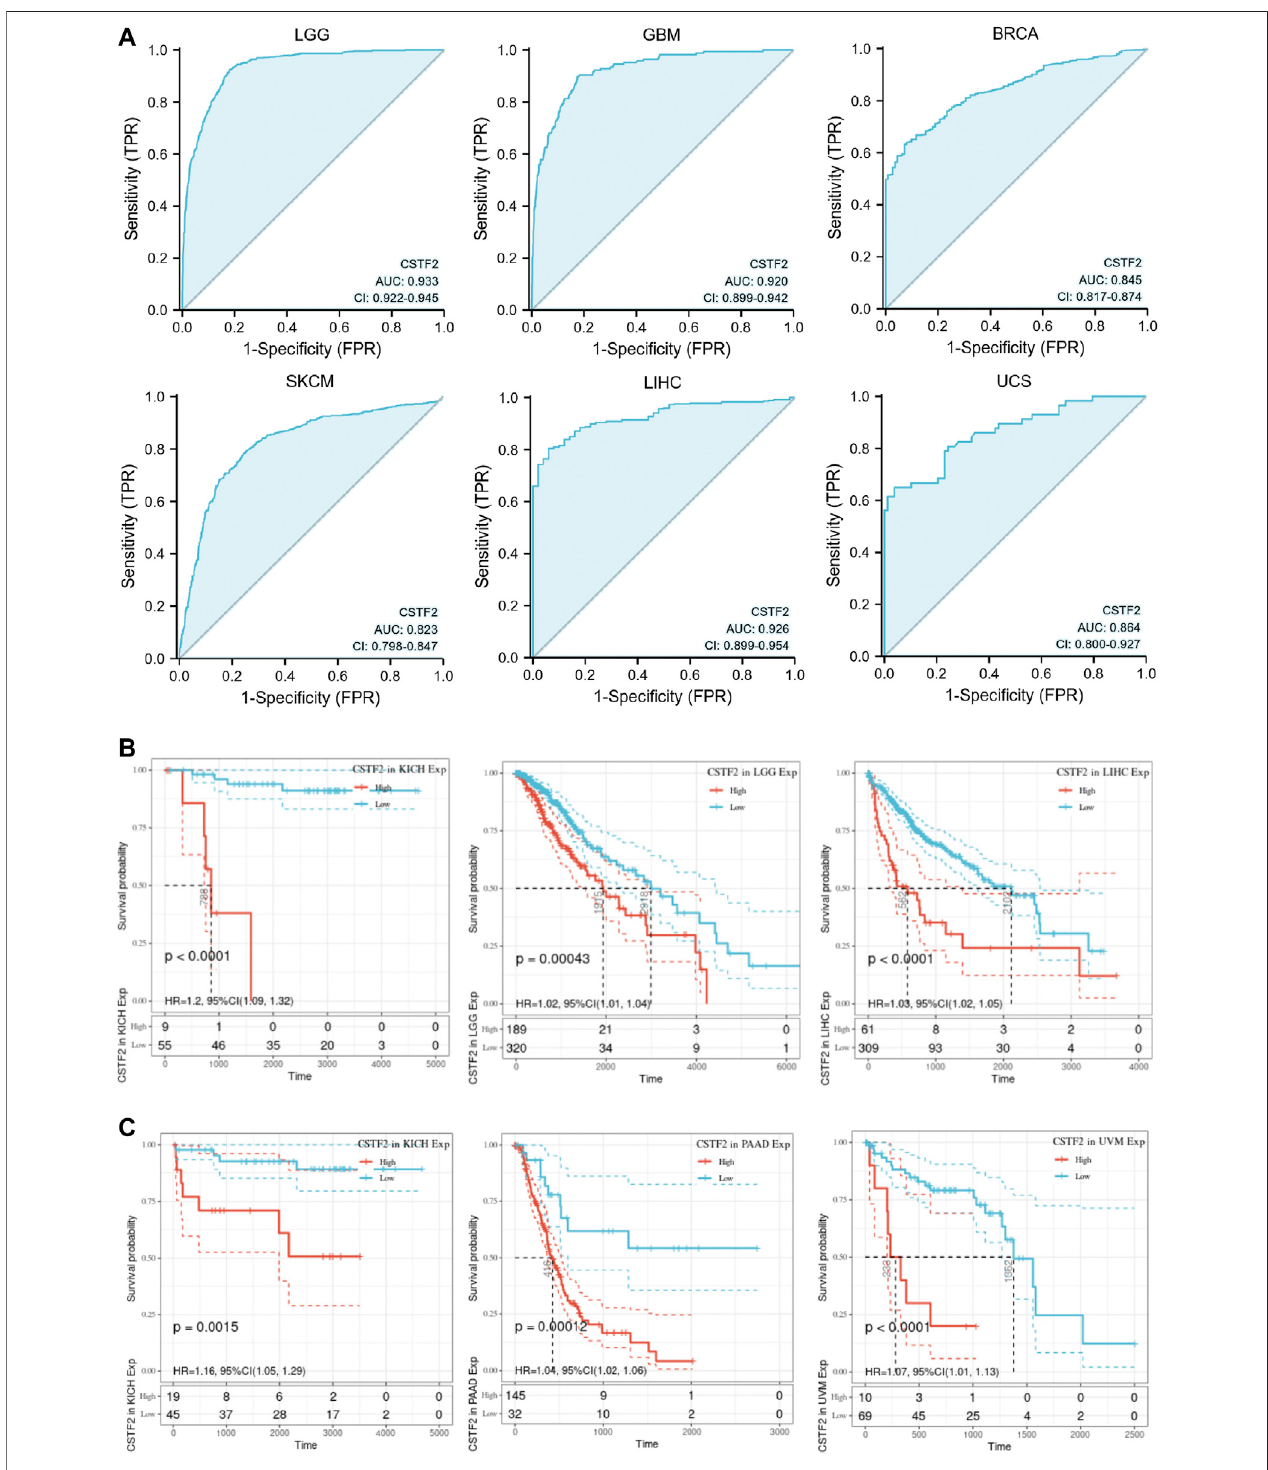
FIGURE7| Relationshipbetween CSTF2 anddiagnosisandprognosisofmultiplecancers. (A) ROCcurvesof CSTF2 inmultiplecancers. (B) Overallsurvivalcurve. (C) Progression-free survival curve.